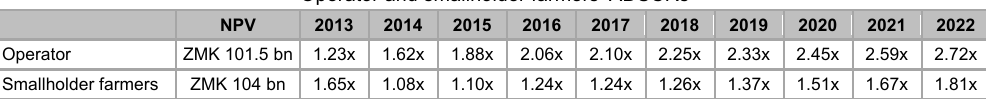
Operator and smallholder farmers’